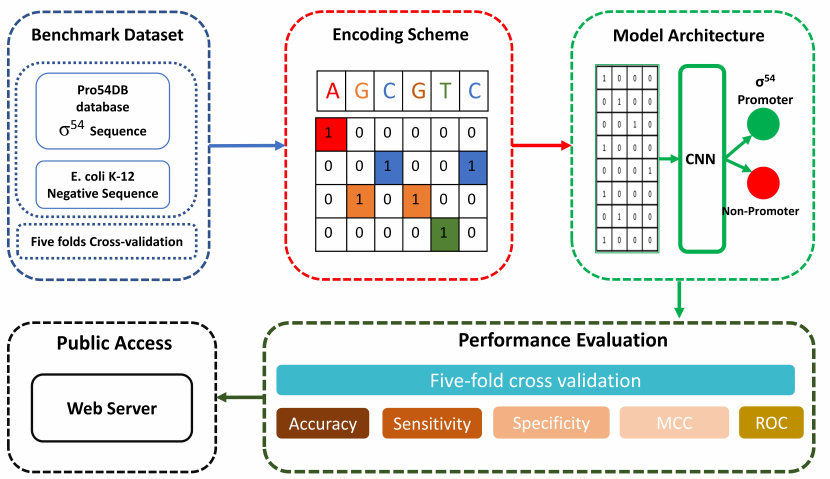
Figure 1. iProm-Sigma54 model flow diagram. We utilized σ 54 promoter sequences from the “Pro54DB” database and performed one-hot feature encoding scheme, after that we input encoded sequence to a optimal CNN model and later performed performance evaluation and finally made web server.